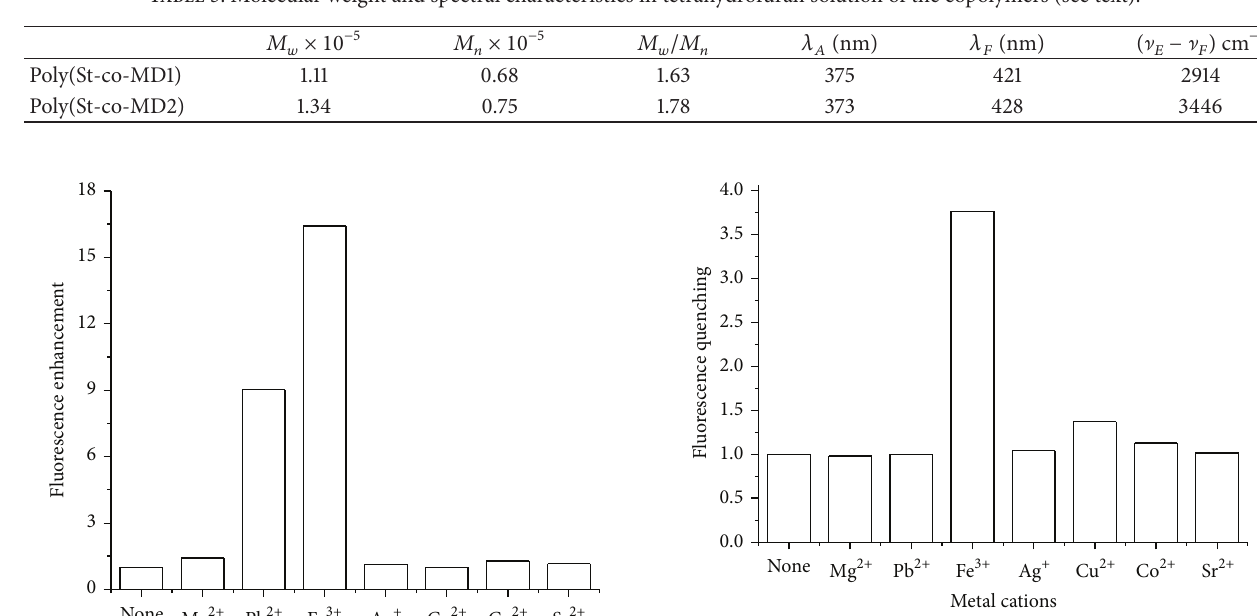
Table 3: Molecular weight and spectral characteristics in tetrahydrofuran solution of the copolymers (see text).